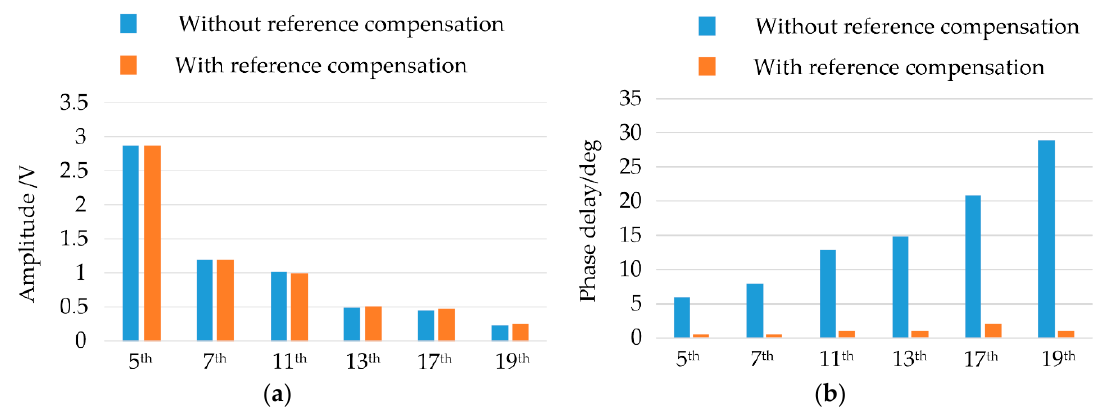
Figure 14. Experimental result. ( a ) Without reference compensation; ( b ) with reference compensation.